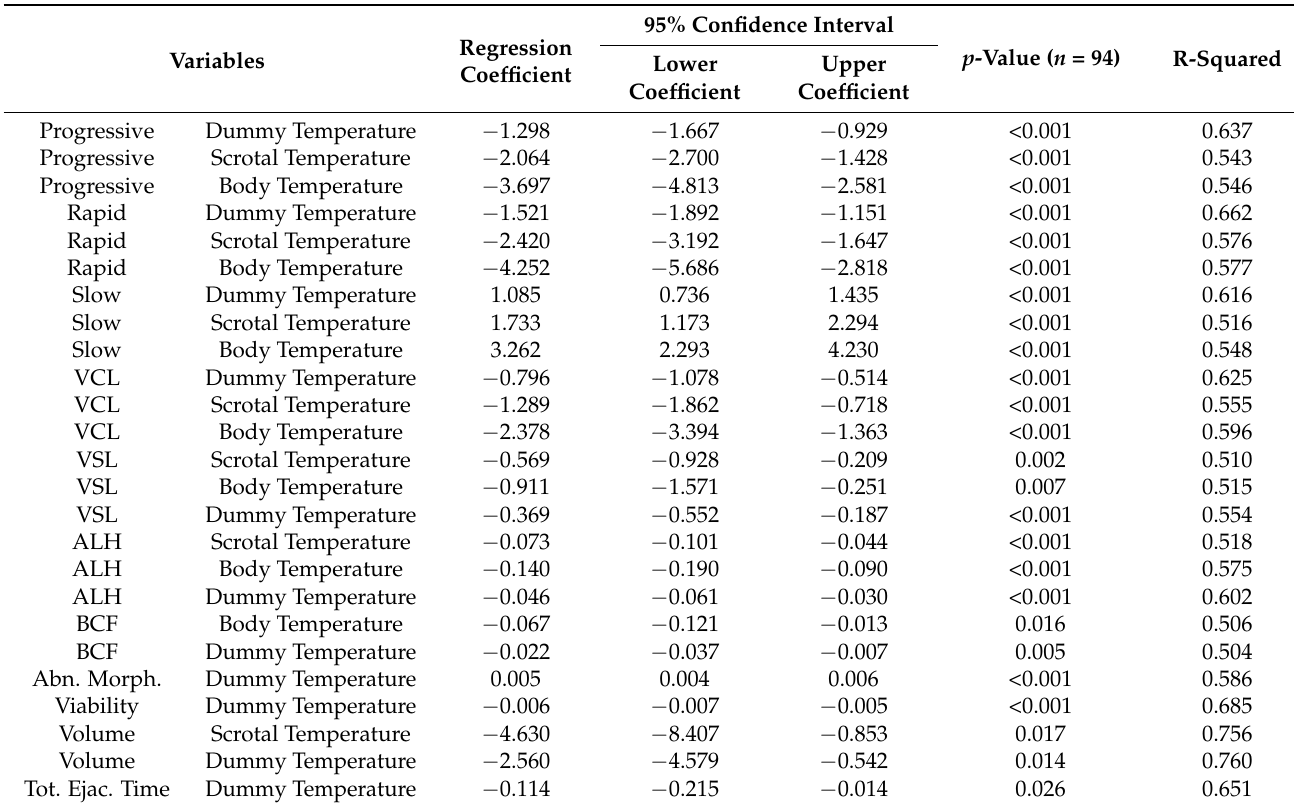
Table 1. Correlations that were significant at p < 0.05 between sperm variables and thermal data.